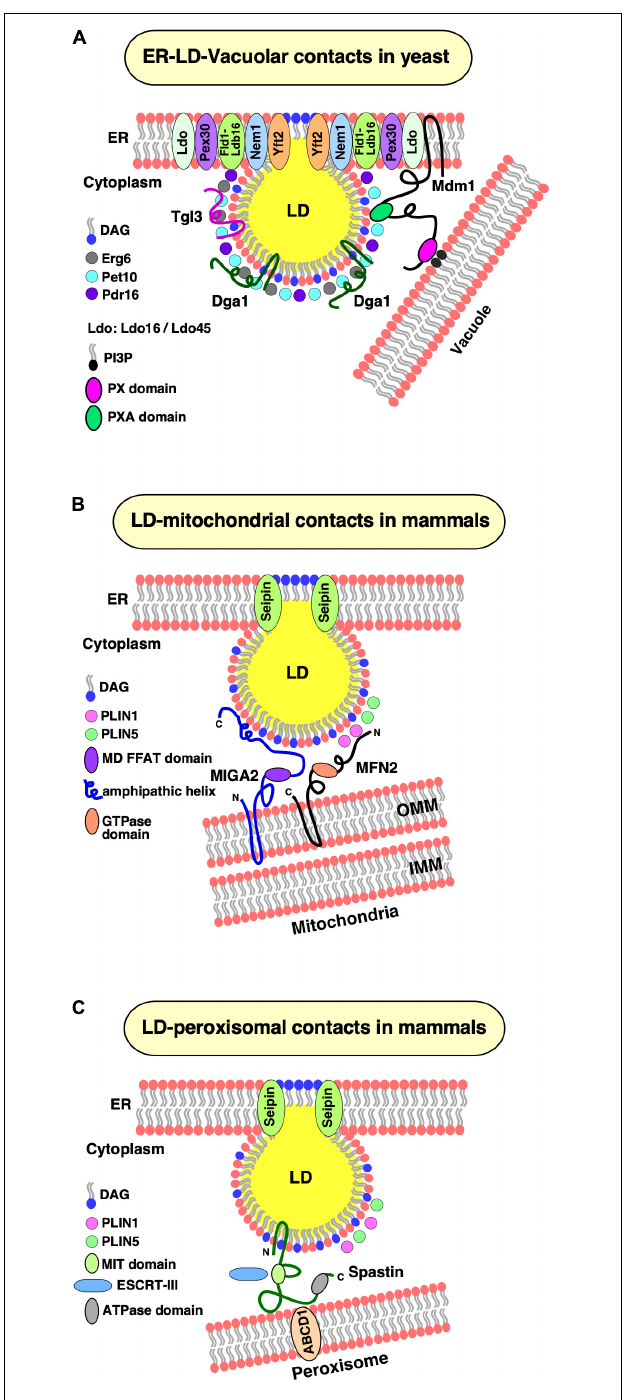
FIGURE 3 | LD contacts with cellular organelles. (A) Establishment of ER–LD–vacuolar contacts in yeast. Yeast cells accumulate LDs at nuclear–vacuolar junctions (NVJ) during starvation. Under these conditions, components of the lipid droplet organization (Ldo) machinery (Ldo16 and Ldo45) coenrich with the Fld1–Ldb16 complex at ER–LD contact sites. Yeast Mdm1 also localizes at these sites and bridges three organelles together, the ER, LDs, and the vacuole. The PX domain of Mdm1 interacts with PI3P in the